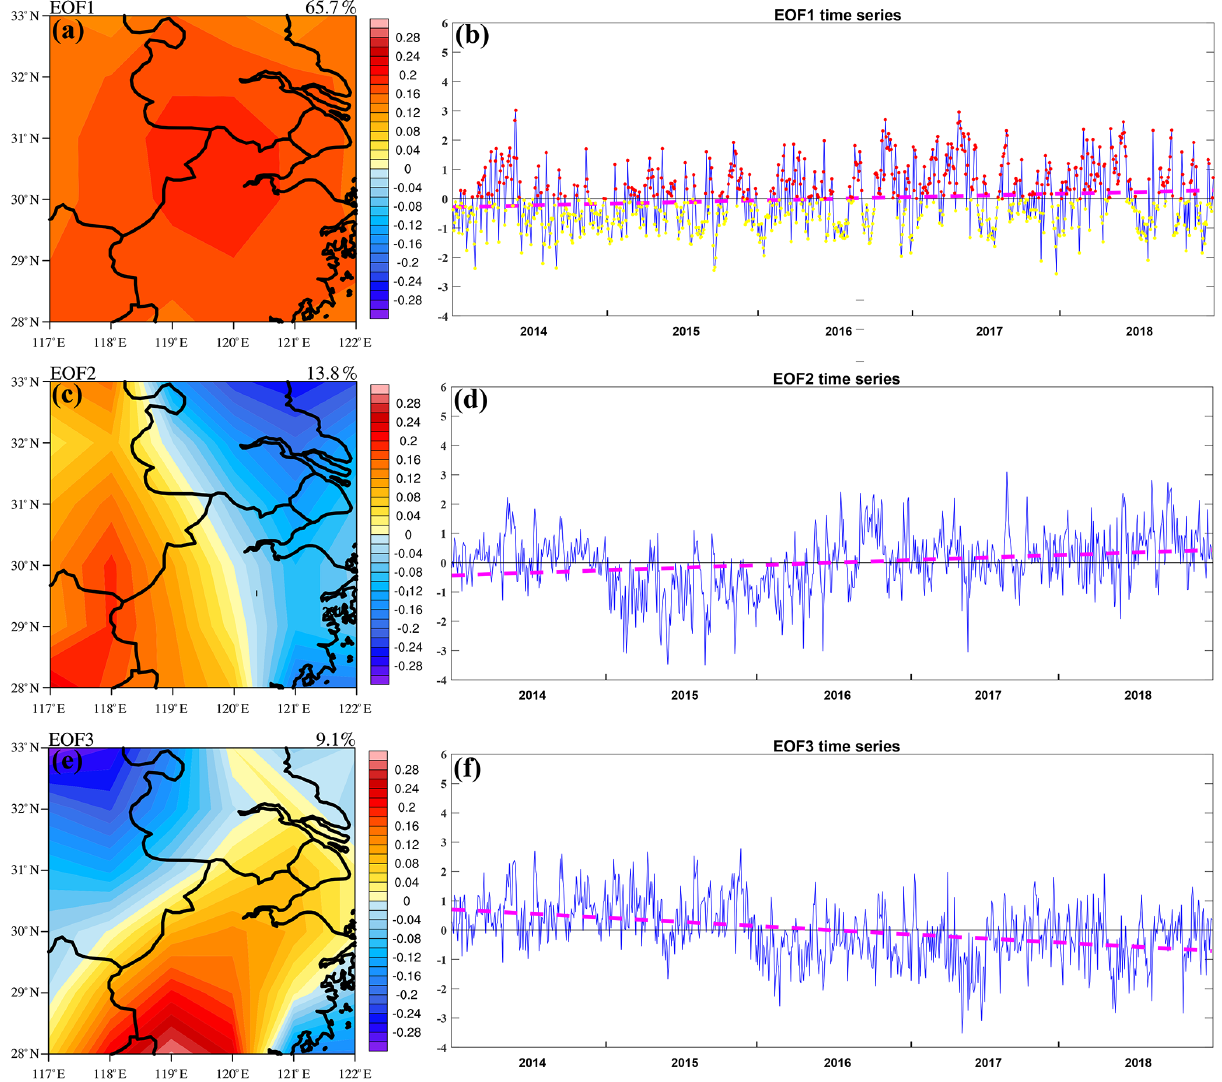
Figure 2. Three EOF patterns of O 3 concentration in the warm seasons from 2014 to 2018, including the spatial pattern (a, c, e) and time coefficient (b, d, f) . The percentages in panels (a) , (c) and (e) are the variance contributions of each EOF mode. The dashed pink line in panels (b) , (d) and (f) represents the linear fitted